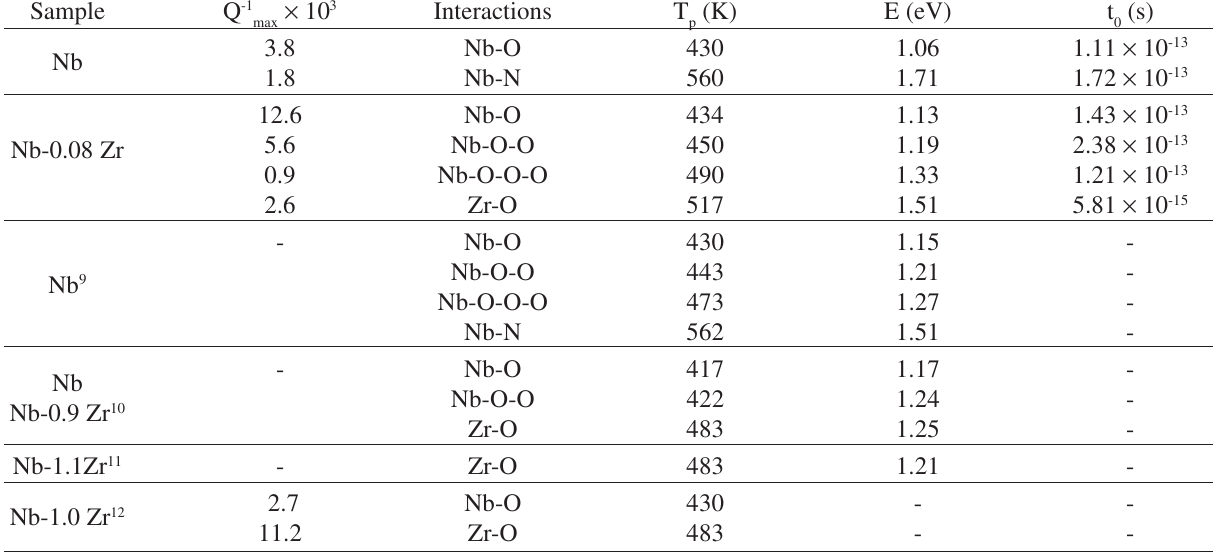
Table 1. Relation rate parameters of Nb-O, Nb-N and Zr-O interactions.